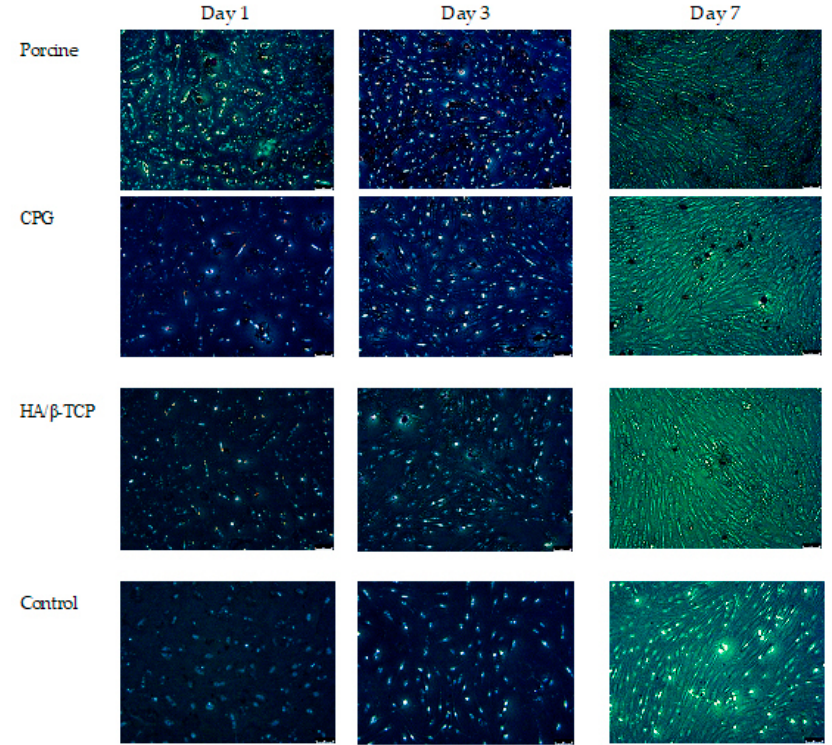
Figure 3. Fluorescence microscopy of MG-63 cells co-cultured with particle graft medium. Changes in MG-63 cell morphology and spreading at one, three, and seven days. (magnification 20×).